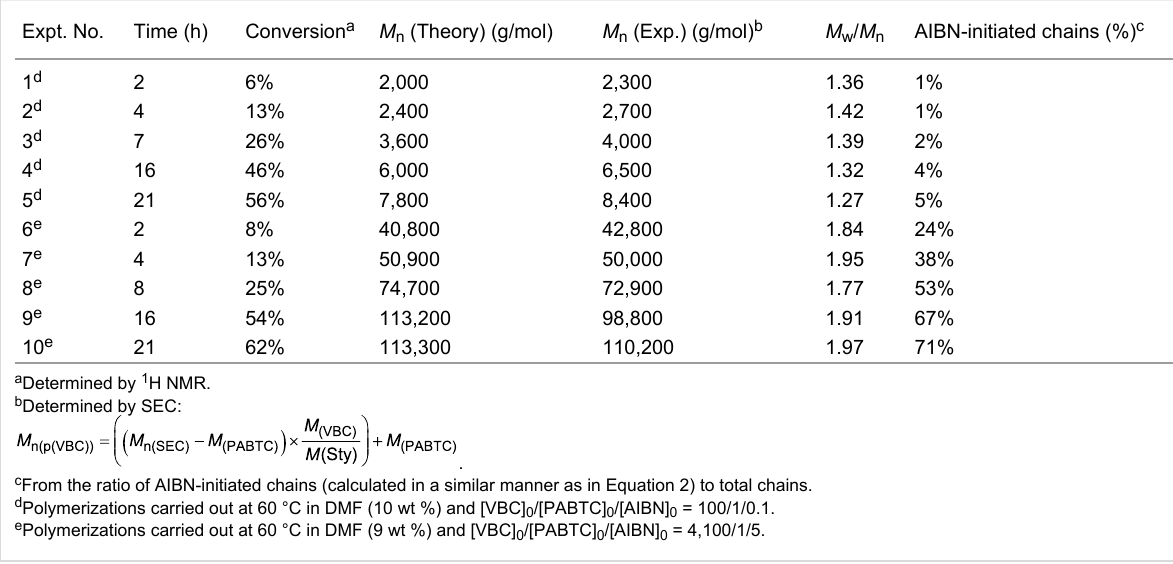
Table 1: Characteristics of polymers produced by the AIBN-initiated, PABTC-mediated polymerization of VBC at 60 °C. Expt.